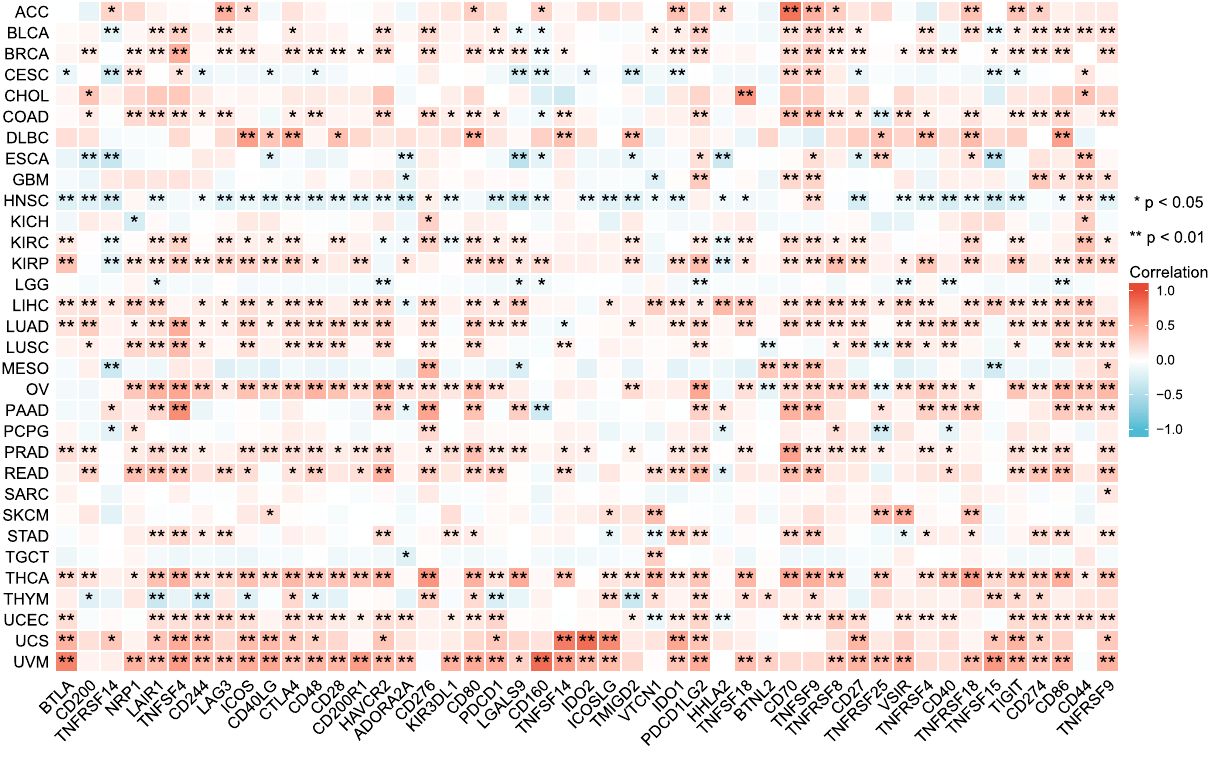
Figure 4. Correlation of IGFL2 with immune